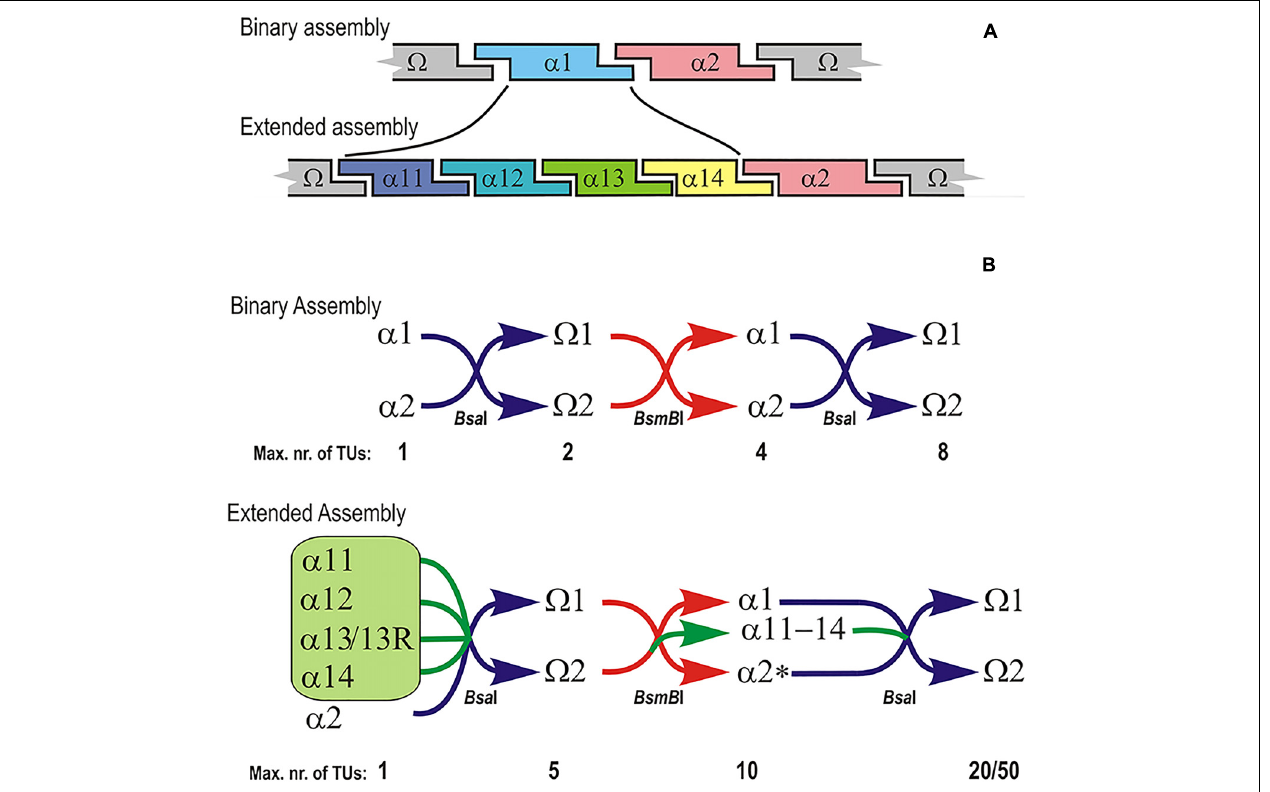
FIGURE 1 | Schematic representation of the design of extended GoldenBraid assembly framework. (A) In the extended assembly the original α 1 plasmid is replaced with 4 novel α -level plasmids in such a way that the 5 (cid:48) end of α 11 and 3 (cid:48) end of α 14 are identical to the ends of original α 1. α 2 and both (cid:127) 1 and 2 plasmids are retained from GoldenBraid 2.0 system. (B) Examples of infinite loops in classical binary GoldenBraid assembly vs. extended assembly with the maximum number of assembled transcription units (Sarrion-Perdigones et al.,